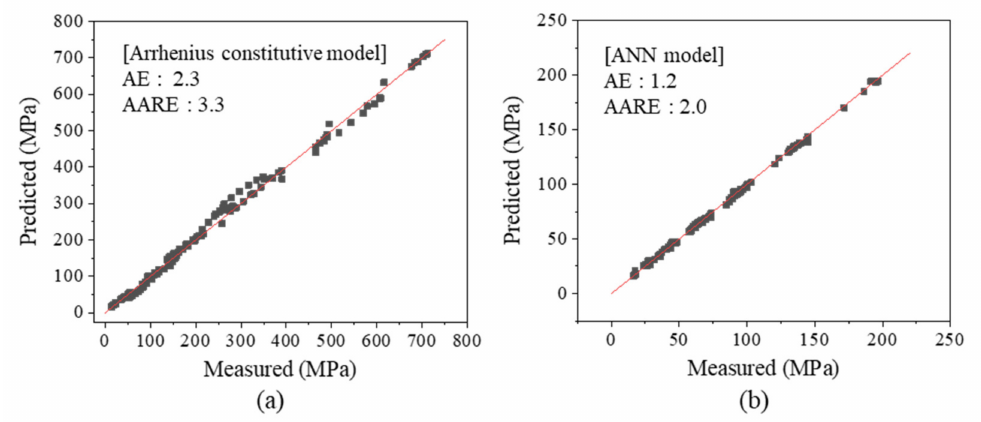
Figure 9. Correlation relationships between the measured and predicted values using the ( a ) Arrhe- nius constitutive model and ( b ) ANN